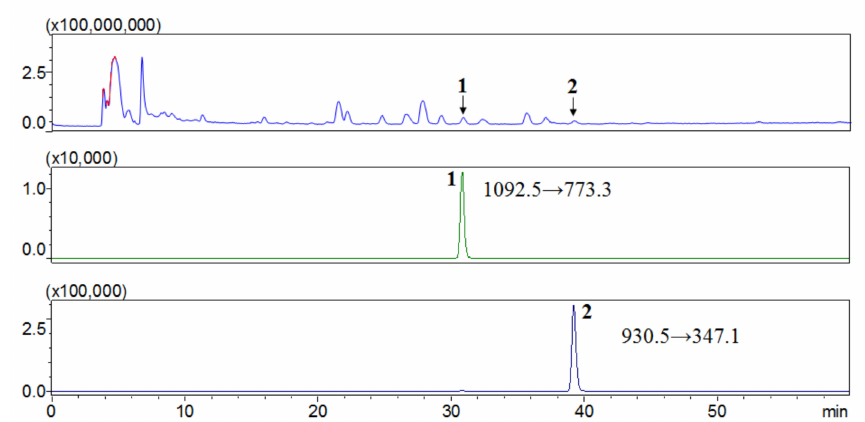
Figure 2. Positive ion mode LC-electrospray ionization (ESI)-MS / MS multiple reaction monitoring (MRM) analysis of EtOH extract of Stauntonia hexaphylla leaves. Profile of the specific transition of compounds 1 and 2 from precursor ion to product ions in the MRM mode.